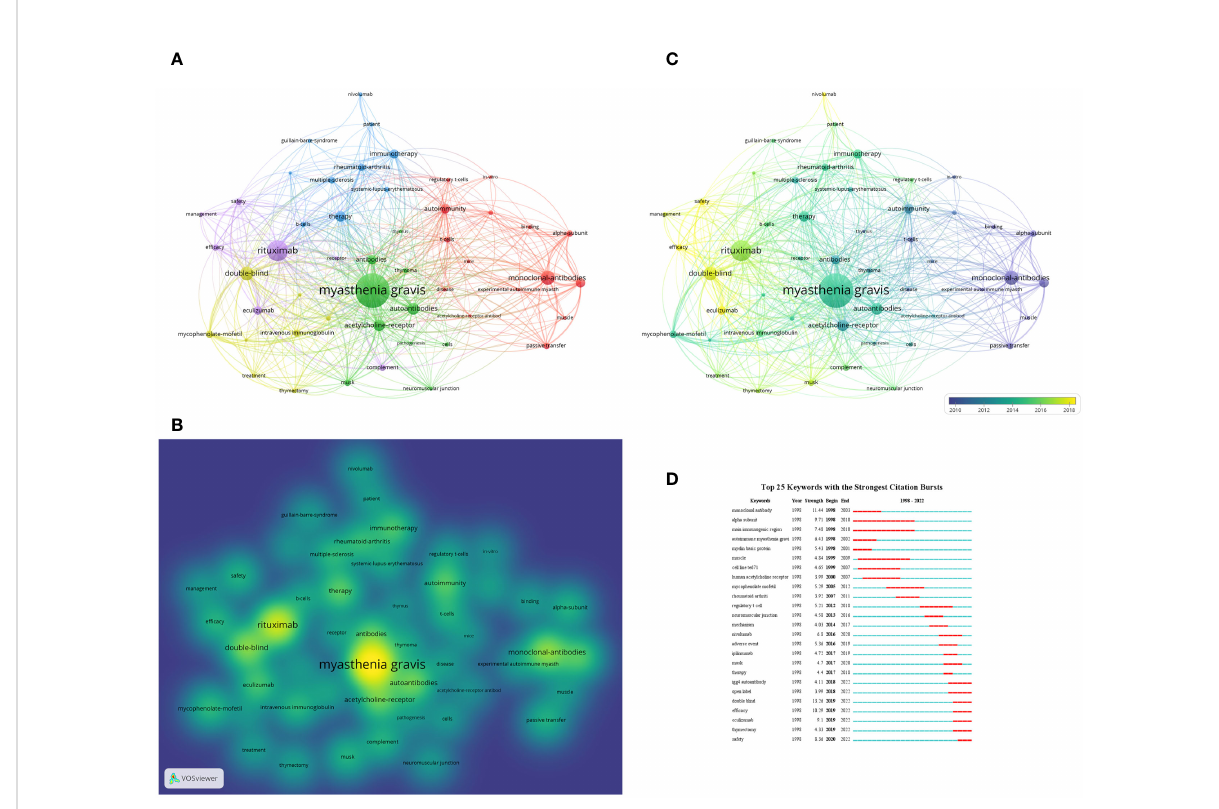
FIGURE 9 (A) Network visualization of keywords based on VOSviewer. In this network map, keywords with close relationship are assigned to one cluster with the same color. All the keywords could be divided into fi ve clusters: cluster 1 (red nodes), cluster 2 (green nodes), cluster 3 (blue nodes), cluster 4 (yellow nodes) and cluster 5 (purple nodes). (B) Density visualization of keywords based on VOSviewer. (C) Overlay visualization of keywords based on VOSviewer. The nodes marked with purple or blue color represent the keywords that appeared relatively earlier,